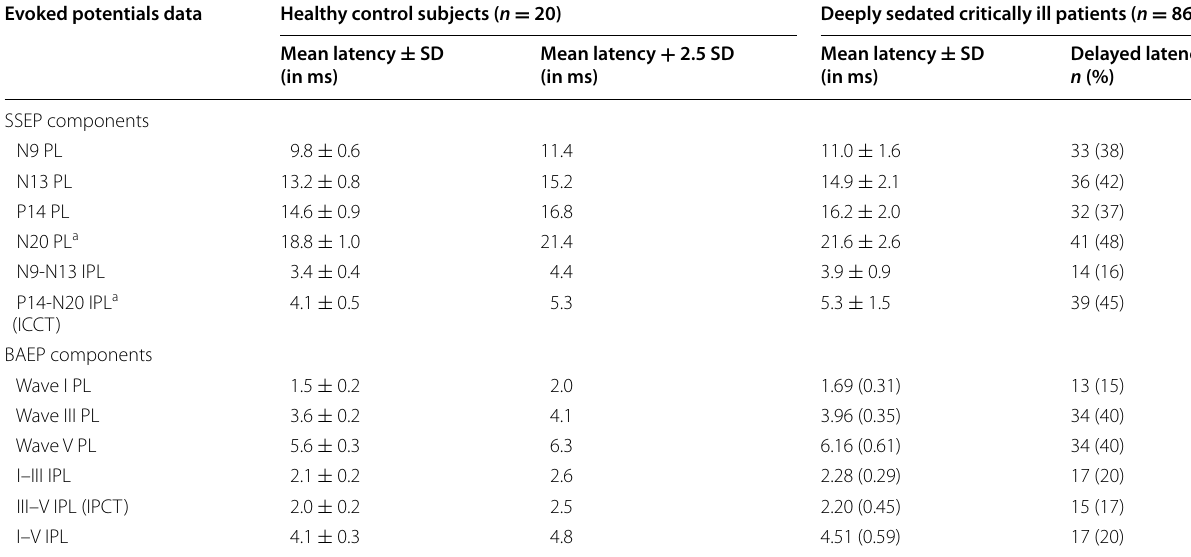
Table 1 Neurophysiological